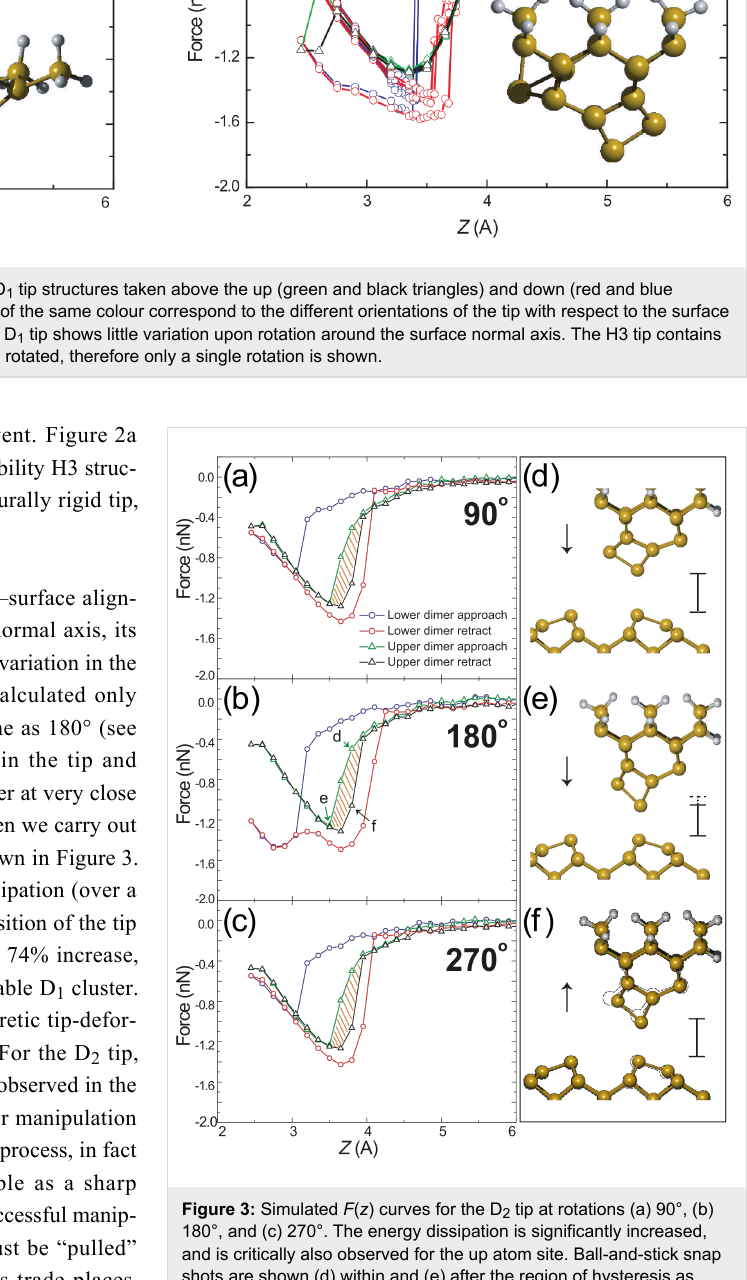
Figure 3: Simulated F ( z ) curves for the D 2 tip at rotations (a) 90°, (b) 180°, and (c) 270°. The energy dissipation is significantly increased, and is critically also observed for the up atom site. Ball-and-stick snap shots are shown (d) within and (e) after the region of hysteresis as indicated in (b) during tip approach. (f) Ball-and-stick snap shot during retraction at the same position as (d), which is shown as a dashed outline, illustrating the alternative structural pathway taken by the tip, thus causing the observed